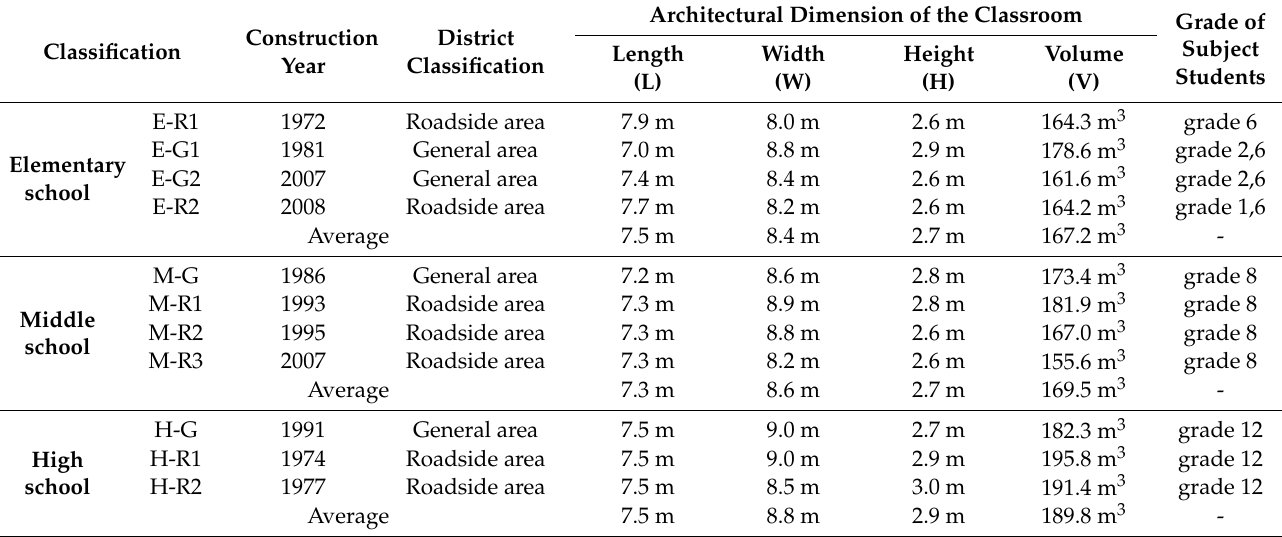
Table 3. Information about the subject schools and